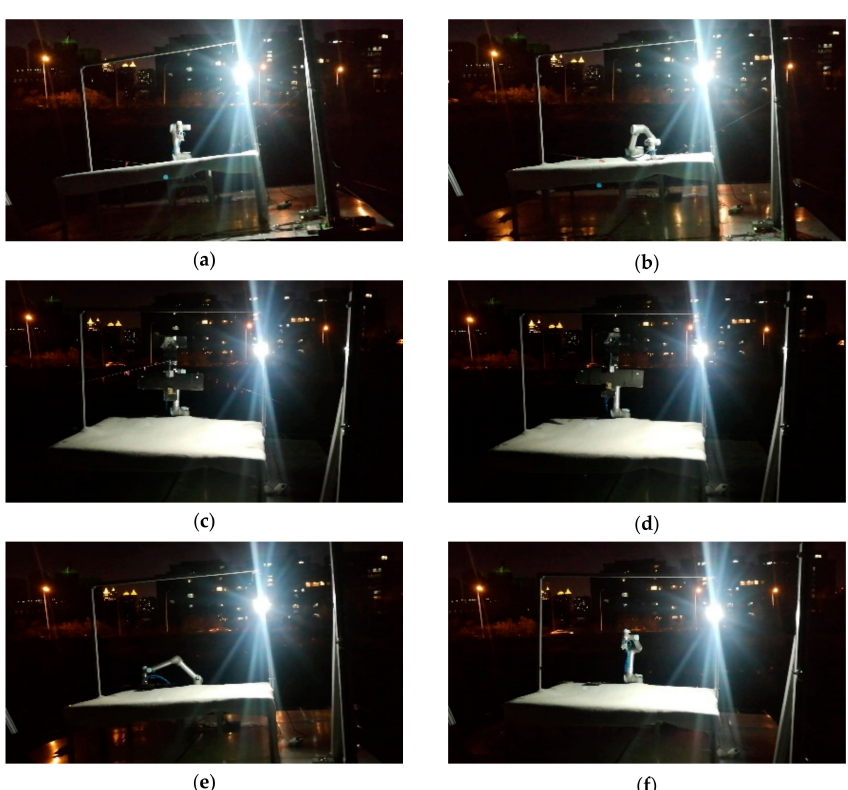
Figure 20. Process of compliance grasp and placing a UAV by the manipulator. ( a ) Start task; ( b ) sucking the UAV; ( c ) raising the drone; ( d ) UAV get out of the arresting cable; ( e ) place the UAV in a storage location; and ( f ) complete the task and return to the original